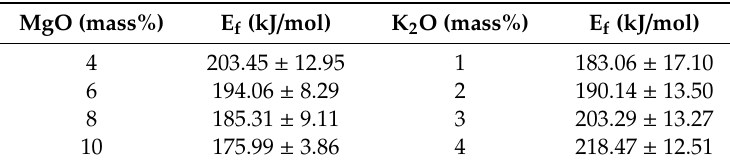
Figure 5. The reciprocal of temperature dependence on the viscosity of the slags ( a ) with a varying MgO content; and ( b ) with a varying K 2 O content. Table 3. The calculated results of apparent activation energy.